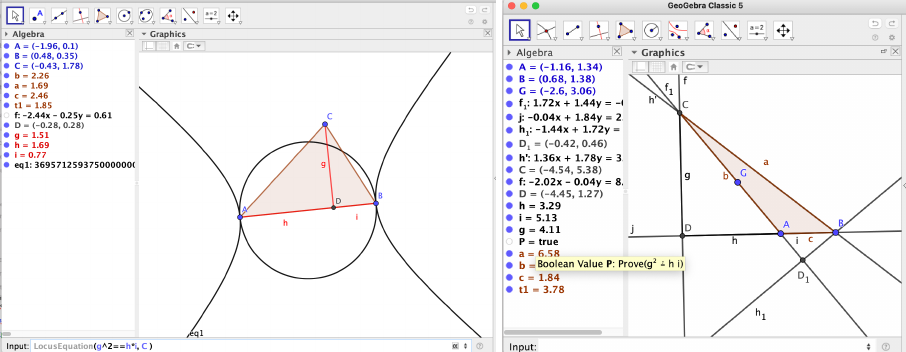
Figure 2. Left, possible locus of C for the validity of the Altitude Theorem. Right, confirmation after placing C on the